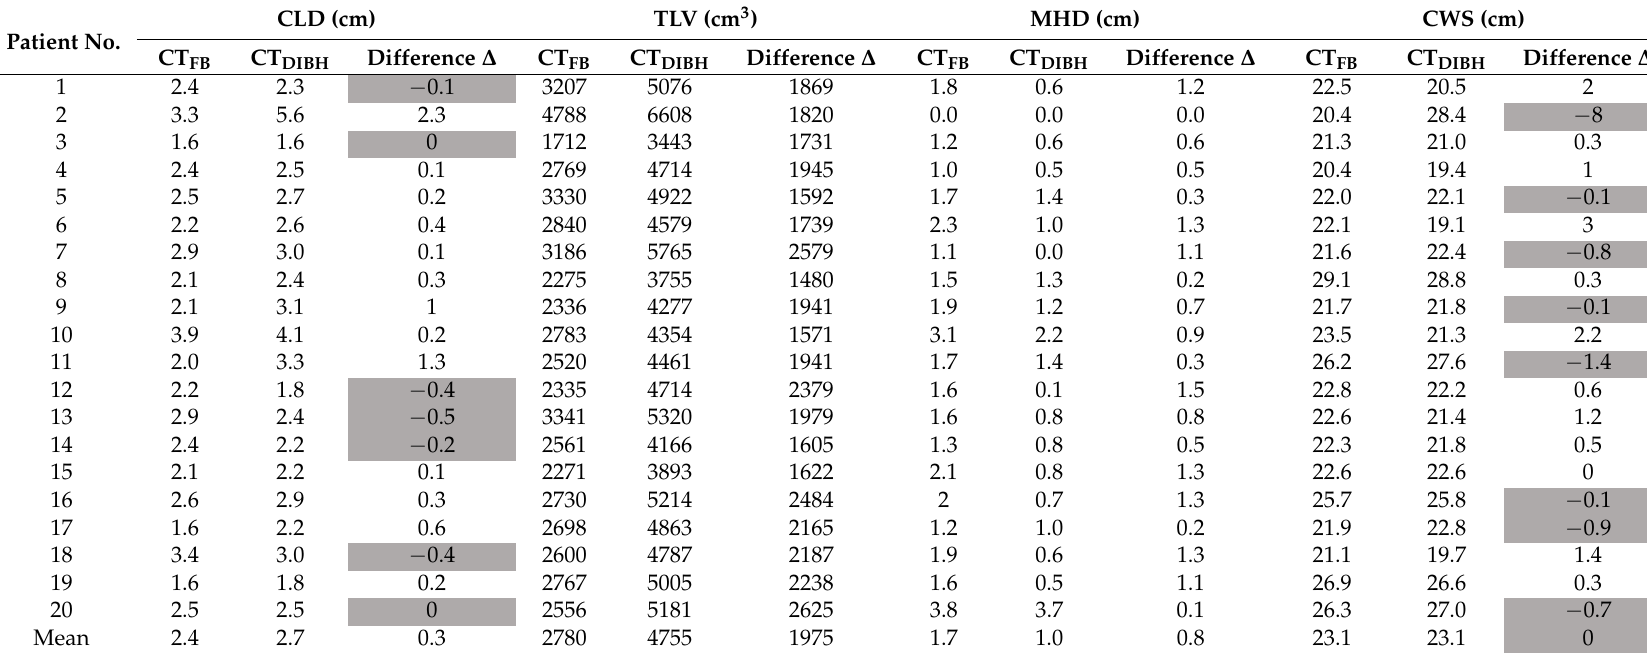
Table 5. CLD, TLV, MHD and CWS from CT FB and CT DIBH plans for individual